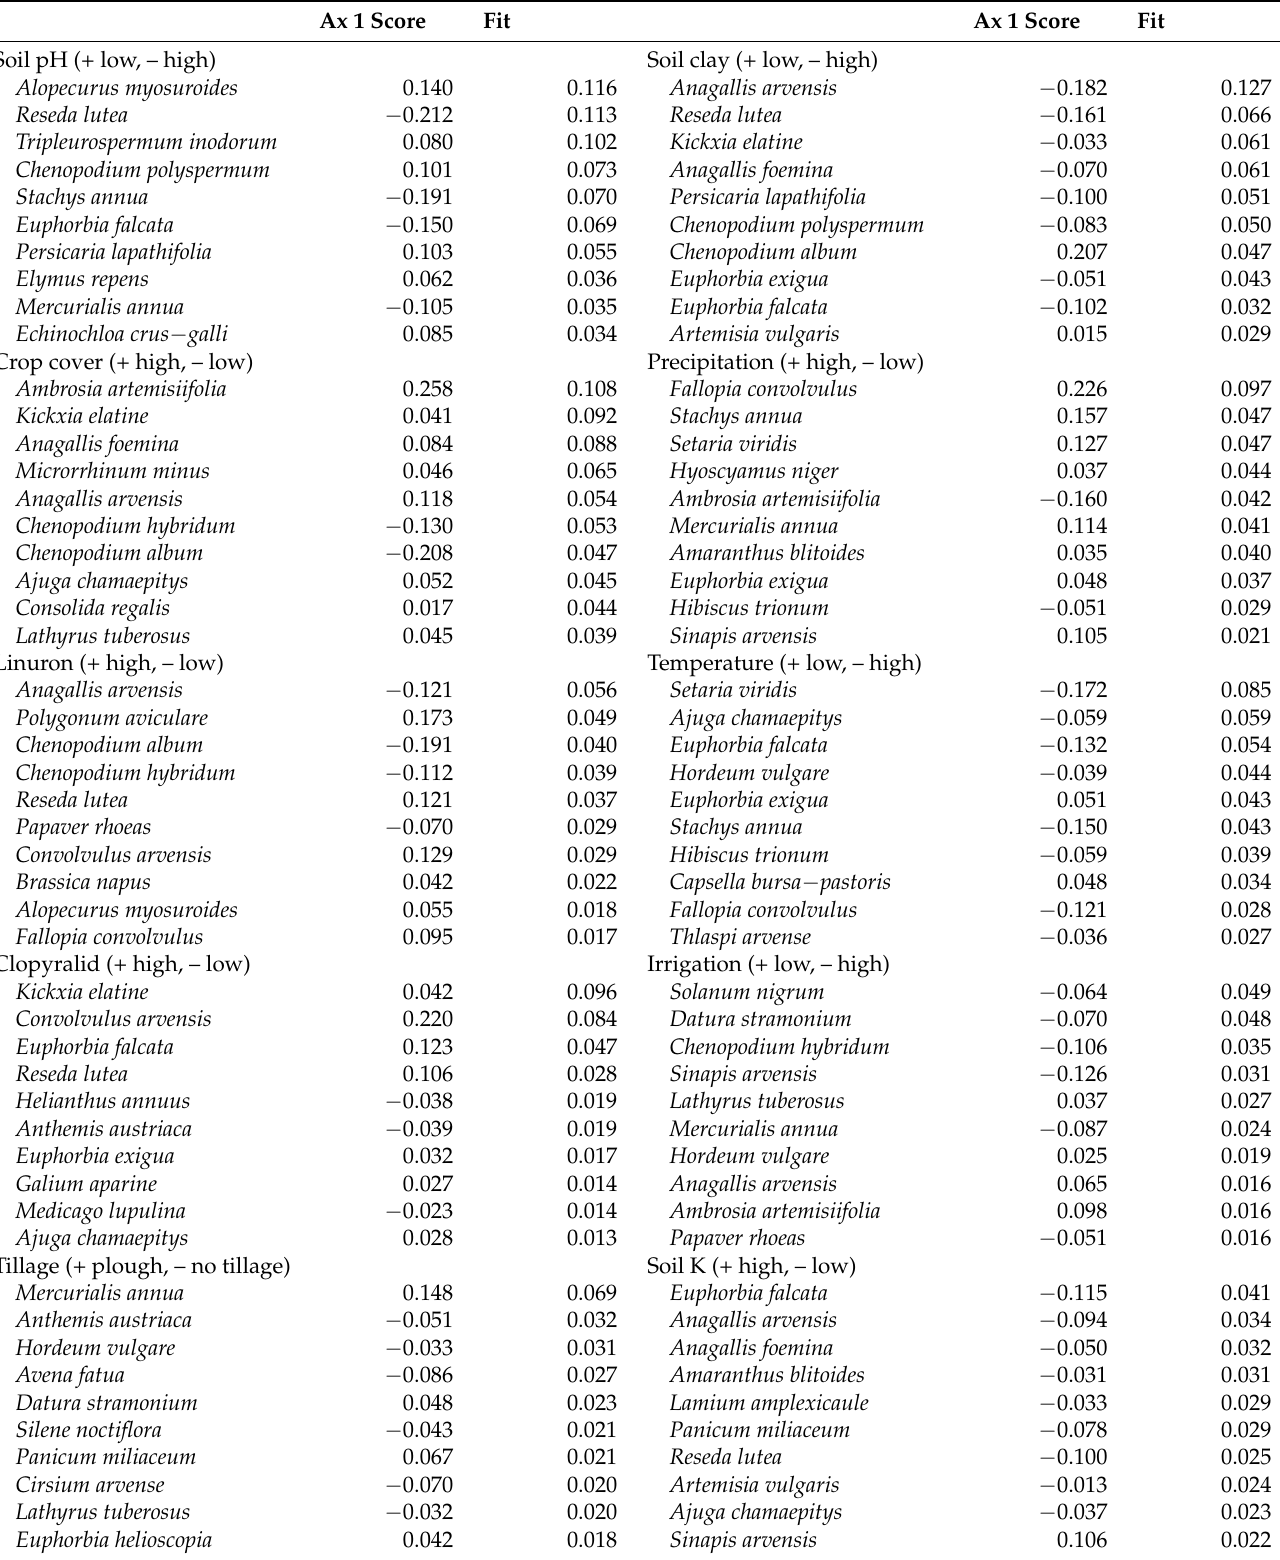
Table 3. Names, fit and score values of species giving the highest fit along the first constrained axis in the partial RDA models of the significant variables specified in Table